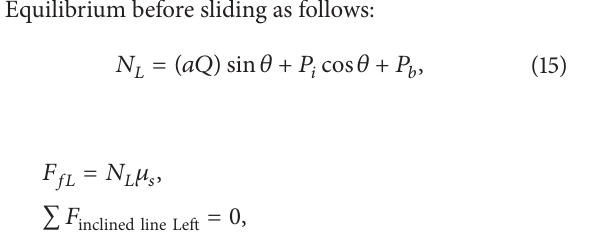
As can be seen from Figure 11, in the case of before thermal effect, the equilibrium equations can be written as two cases (i) before start sliding (15)–(18), and (ii) after start sliding